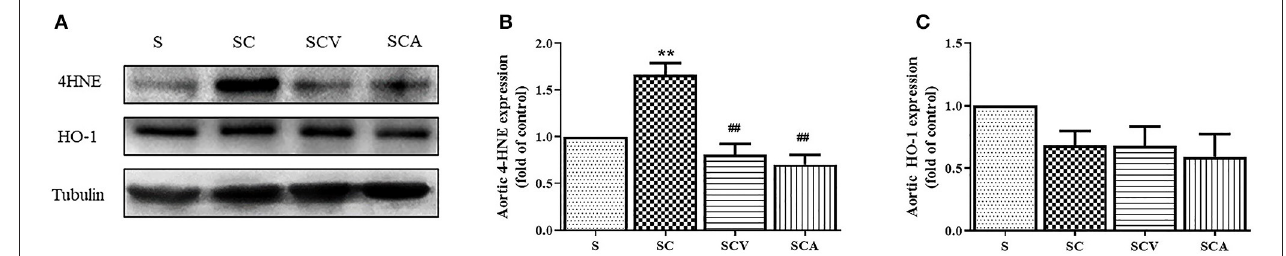
FIGURE 8 | Coconut vinegar supplementation reduced vascular lipid peroxidation. (A) The band of glyceraldehyde 3-phosphate dehydrogenase (GAPDH), 4-hydroxynonenal (4-HNE), and Heme oxygenase-1 (HO-1) expressions of aortic tissues, the proteins expression was determined by western blot analysis in five experiments with independent preparations; (B) Quantified levels of aortic 4-HNE expression; (C) Quantified levels of aortic HO-1 expression. Each bar presented in mean ± SEM. ** p < 0.01 vs. the control group; ## p < 0.01 vs. the SC group ( n = 5 per